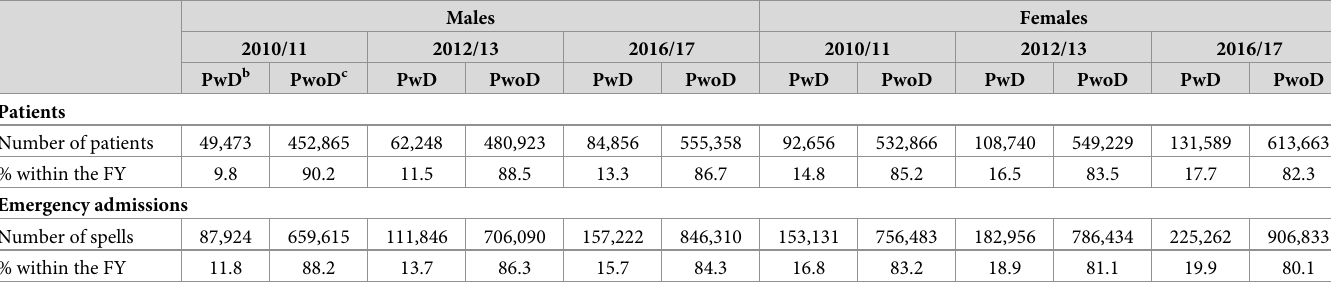
Table 1. Summary of analysis samples a